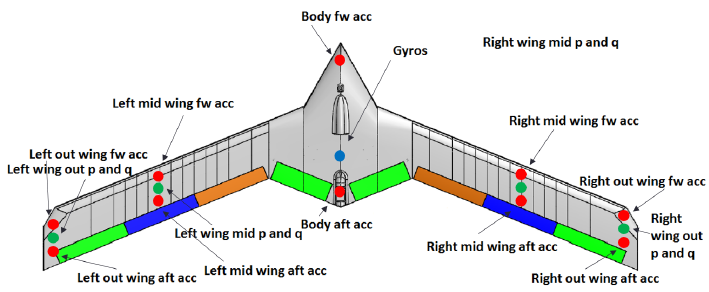
Figure 2. Mini Multi Utility Technology Testbed (MUTT) aircraft [32].